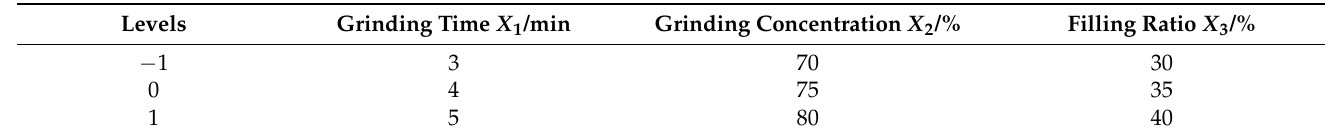
Table 16. Design of factors and levels of response surface method.